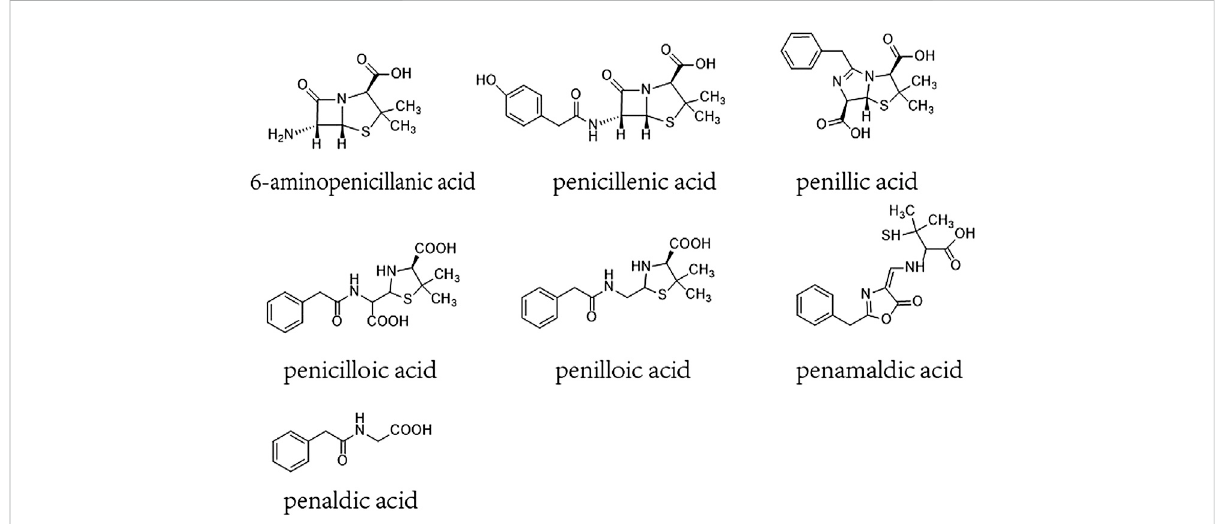
FIGURE 1 Chemical constructions of 6-aminopenicillanic acid, penicillenic acid, penillic acid, penicilloic acid, penilloic acid, penamaldic acid, penaldic